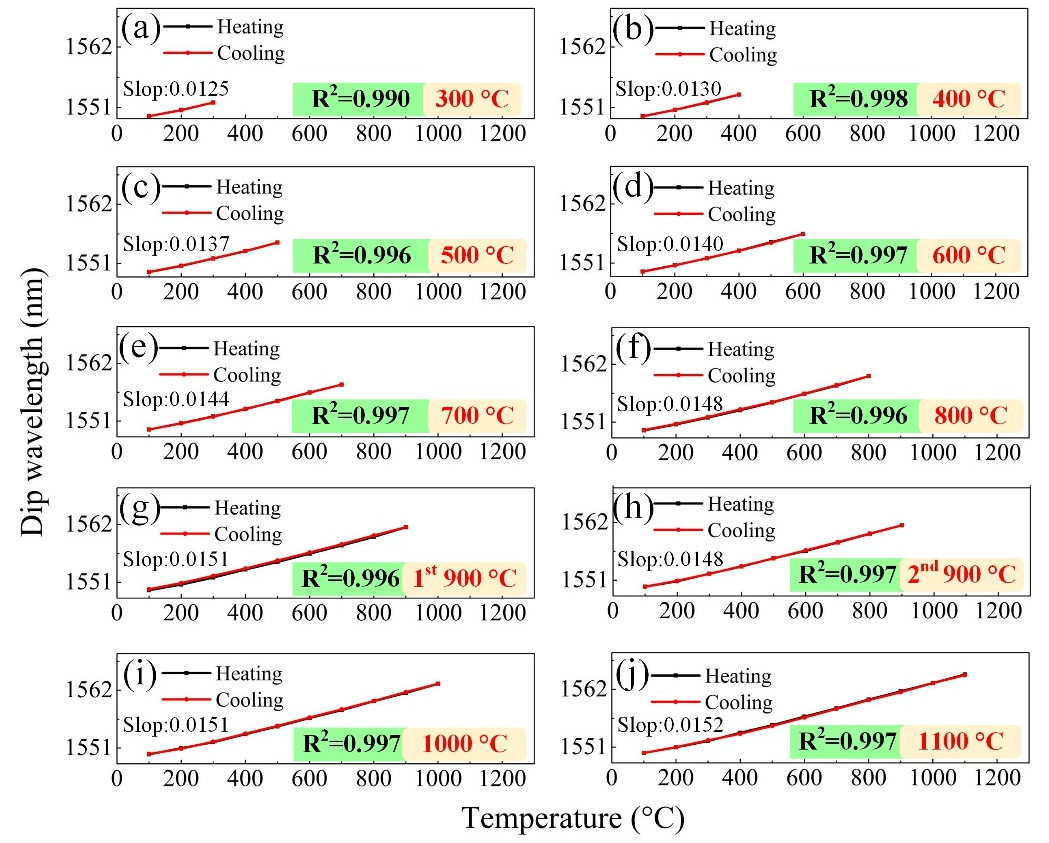
Figure 5. Wavelength of the tracked dip versus temperature for ten temperature ranges of ( a ) 100-300 °C, ( b ) 100-400 °C, ( c ) 100-500 °C, ( d ) 100-600 °C, ( e ) 100-700 °C, ( f ) 100-800 °C, ( g ) 1 st 100-900 °C ( h ) 2 nd 100-900 °C, ( i ) 100-1000 °C, and (j ) 100-1100 °C.